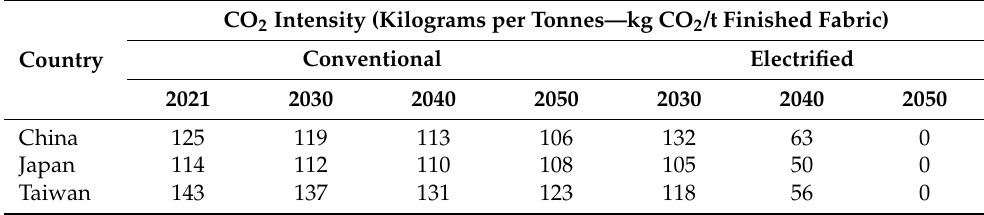
Table 11. The CO 2 intensity of the conventional and electrified mercerizing and washing processes.